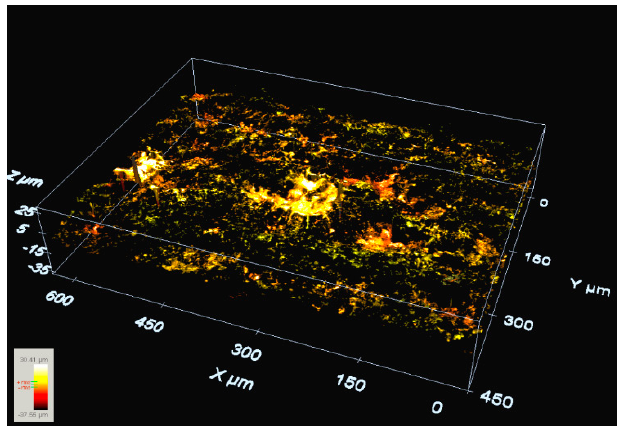
Figure 4. Single crater on a WEDM’ed surface (roughing cut, R a 2.60 µ m, R t 15.27 µ m). The e ff ect of